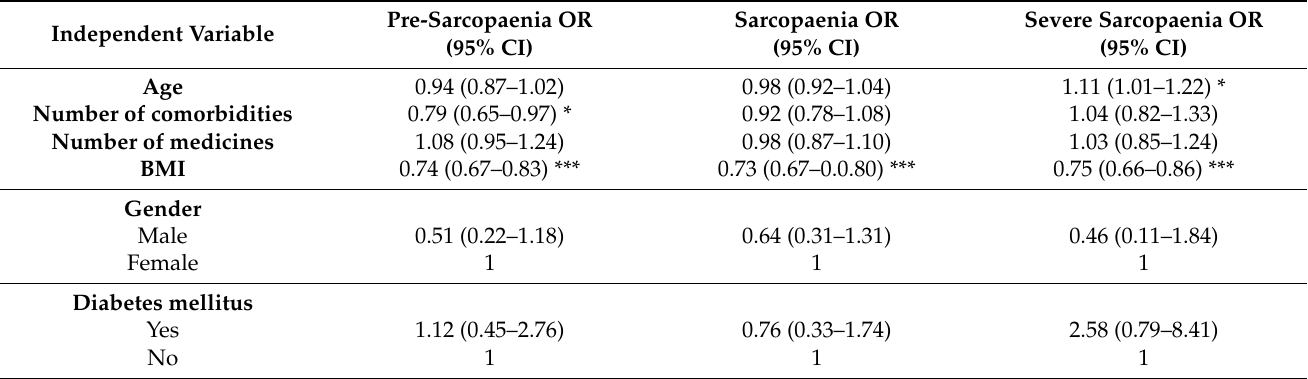
Table 3. Factors related to sarcopaenia. Multinomial logistic regression for pre-sarcopaenia, sarcopae- nia, and severe sarcopaenia states (with respect to